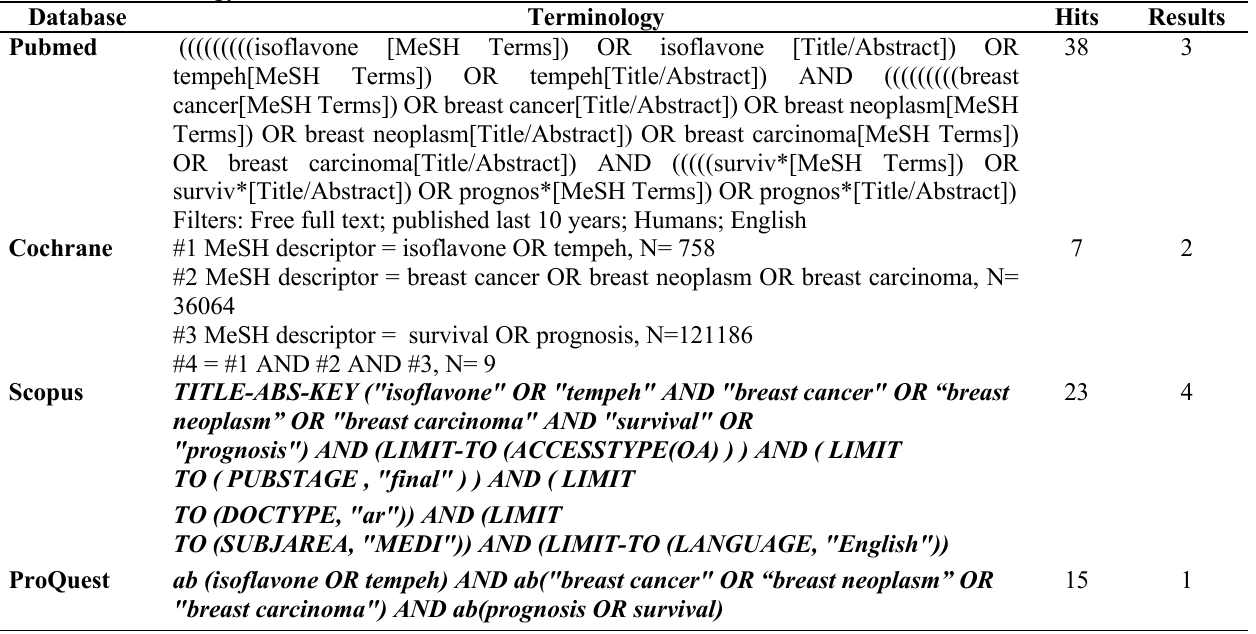
Table 1. Terminology used in four database